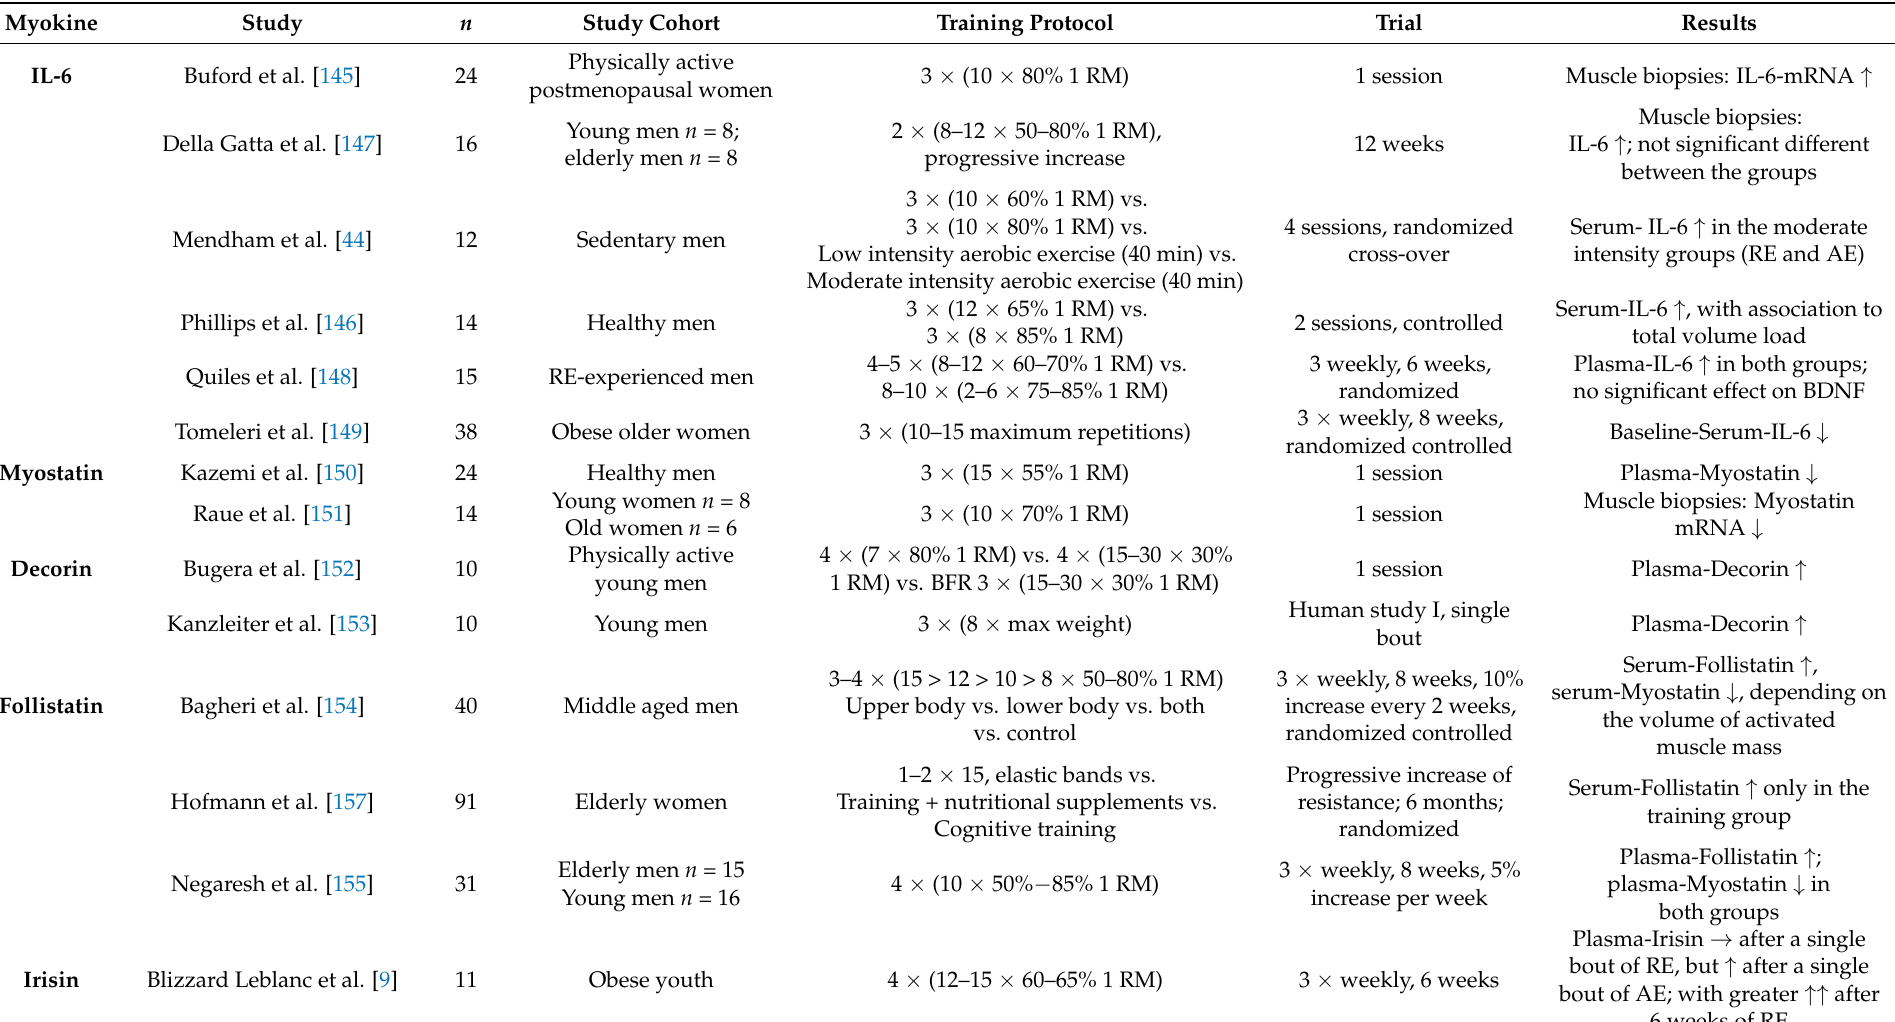
Table 1. Summary of human studies investigating myokine secretion via resistance training